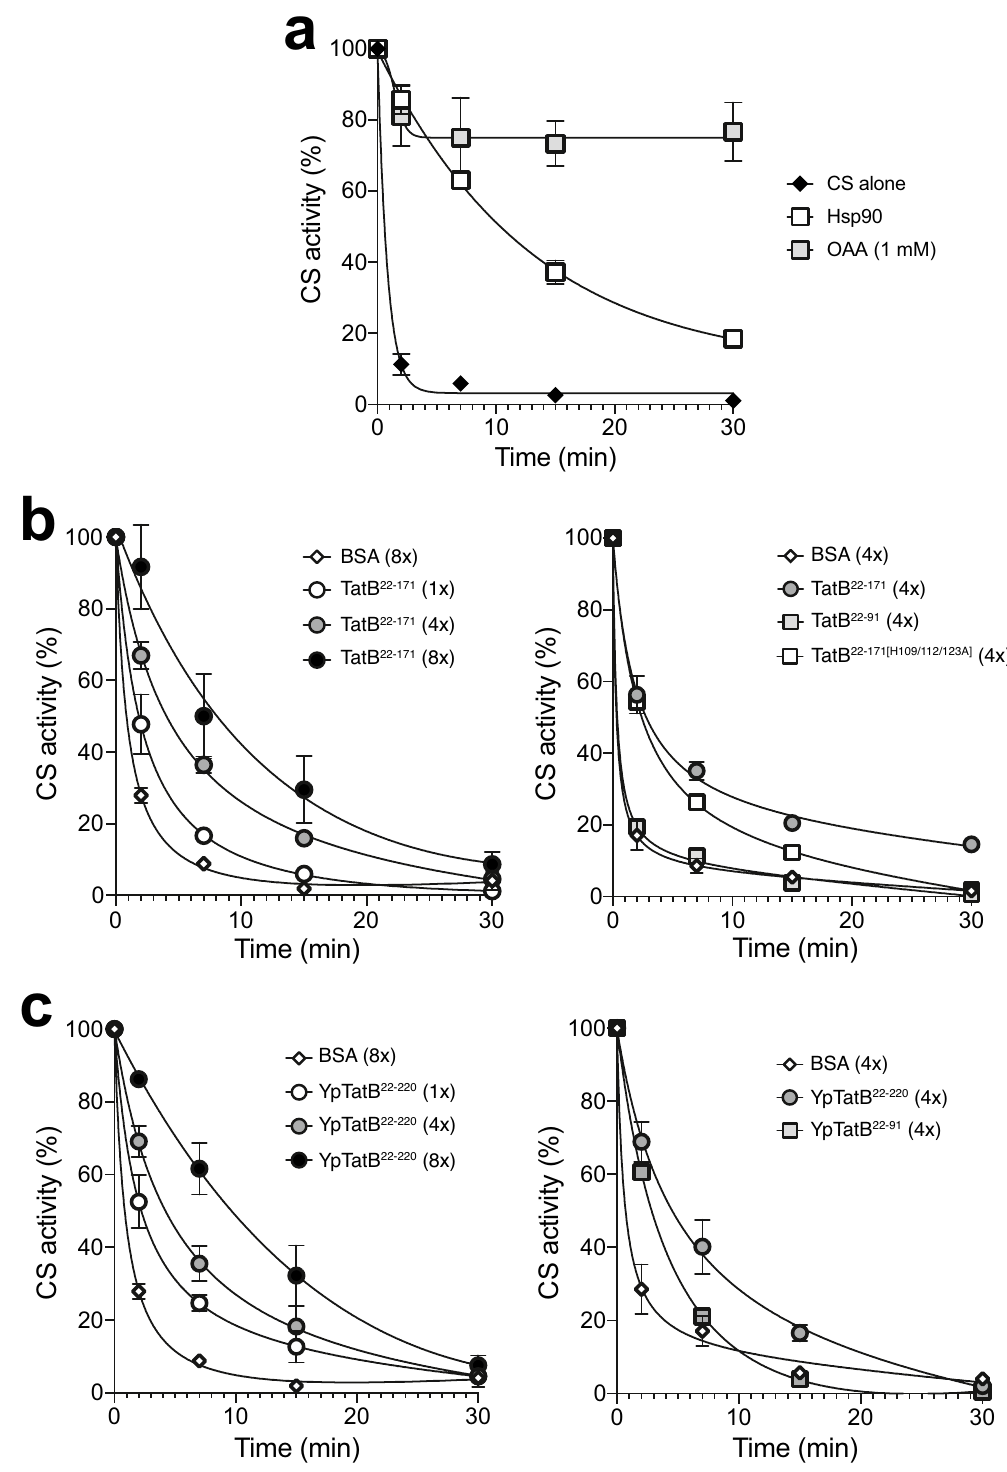
Figure 5. Influence of membrane-extrinsic domain of TatB on thermal inactivation of CS. ( a ) CS (0.15 μM) was incubated at 43 °C either alone or in the presence of 1 mM oxaloacetate (OAA) or equimolar yeast Hsp90 (0.15 μM). ( b ) Same as in ( a ) but in the presence of TatB 22–171 (1x: 0.15 μM; 4x: 0.6 μM, 8x: 1.2 μM), TatB 22–91 (4x: 0.6 μM), or TatB 22–171[H109/112/123A] (4x: 0.6 μM). ( c ) Same as in ( b ) but with YpTatB 22–220 and YpTatB 22–91 . BSA at a concentration of 0.6 μM (4x) or 1.2 μM (8x) served as negative controls. At the times indicated, aliquots were withdrawn and the activity was determined as described. The solid lines represent single exponential functions fit to the experimental data using Prism 8 software. Data are the average of biological replicates and the error bars represent the standard